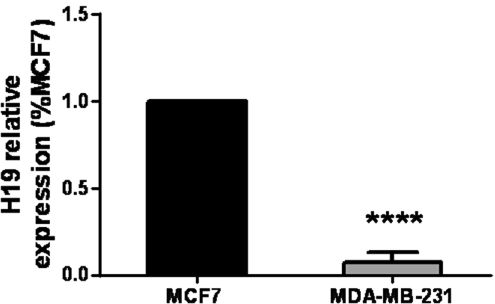
Figure 4. H19 basal levels in MCF-7 and MDA-MB-231 cells. MCF-7 triple positive cells present higher H19 basal levels in comparison with the MDA-MB-231 les differentiated and more invasive triple negative cells. Results were expressed as means ± SD. t-test, ****p < 0.0001